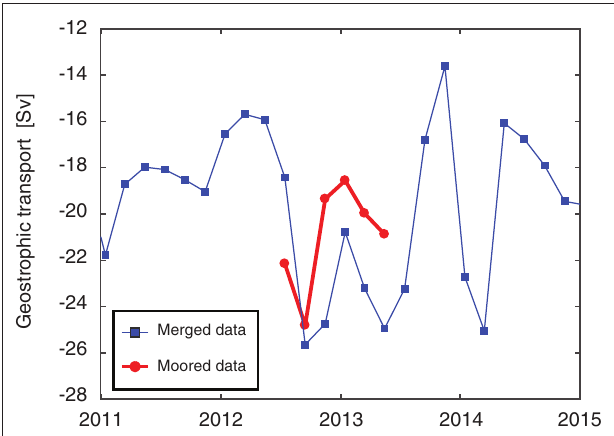
FIGURE 7 | Time series of the absolute geostrophic transport normal to the PX30 nominal track in the EAC region west of 155.3 ◦ E from 2011 to 2015, computed using merged high-resolution XBT (HR-XBT), satellite altimetry, and Argo profiles and trajectory data, are shown in blue. Transport estimates using moored data at 27 ◦ S are indicated in red. Both series are smoothed with a 4-month running mean. Transport estimates averaged between April 2012 and August 2013, are 23.3 Sv using the HR-XBT/Argo/altimetry method, and 21.1 Sv from moored